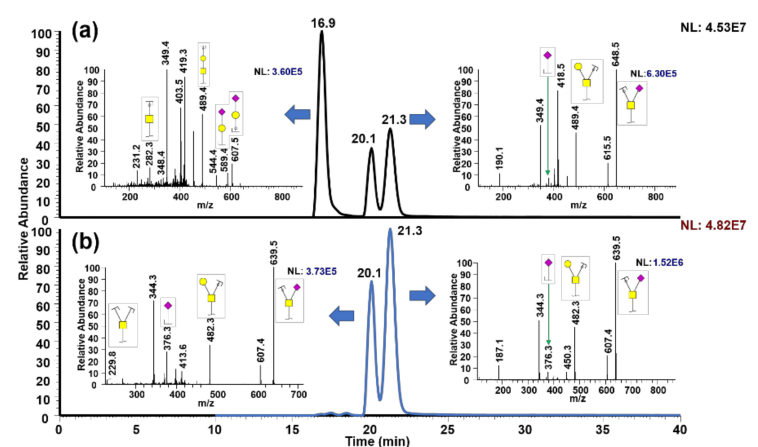
Figure 1. Isomeric separation of permethylated O-glycan isomers derived from k-casein using porous graphitized carbon-liquid chromatography coupled with mass spectrometry (PGC-LC-MS). ( a ) and ( b ) are examples of O -glycan isomers: the peak at 16.9 min represents GalNAc-Gal-NeuAc, and the peaks at 20.1 and 21.3 min represent anomers of GalNAc(NeuAc)-Gal. Insets are MS2 spectra of corresponding